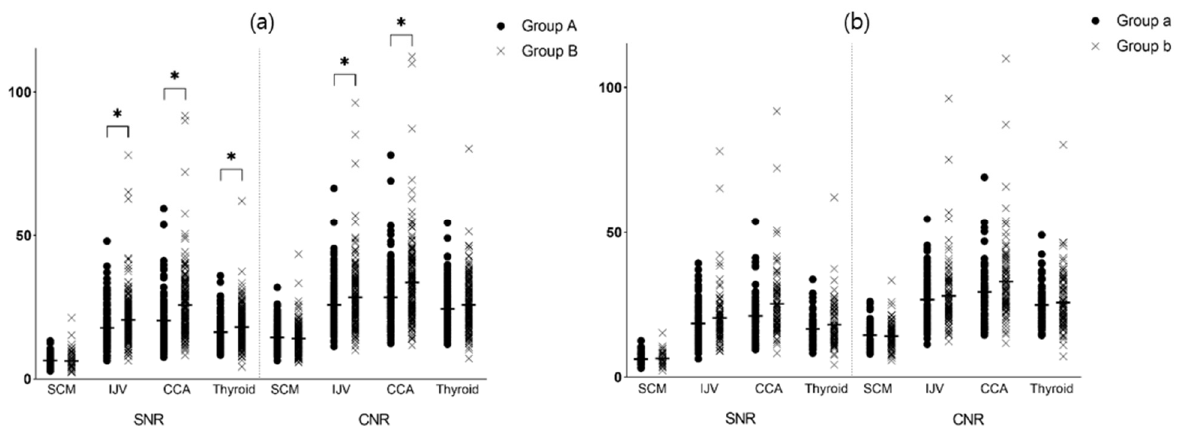
Figure 4. Differences in SNR and CNR between ( a ) Group A and B; and ( b ) Group a and b. * = p -value < 0.05, Student’s t -test.